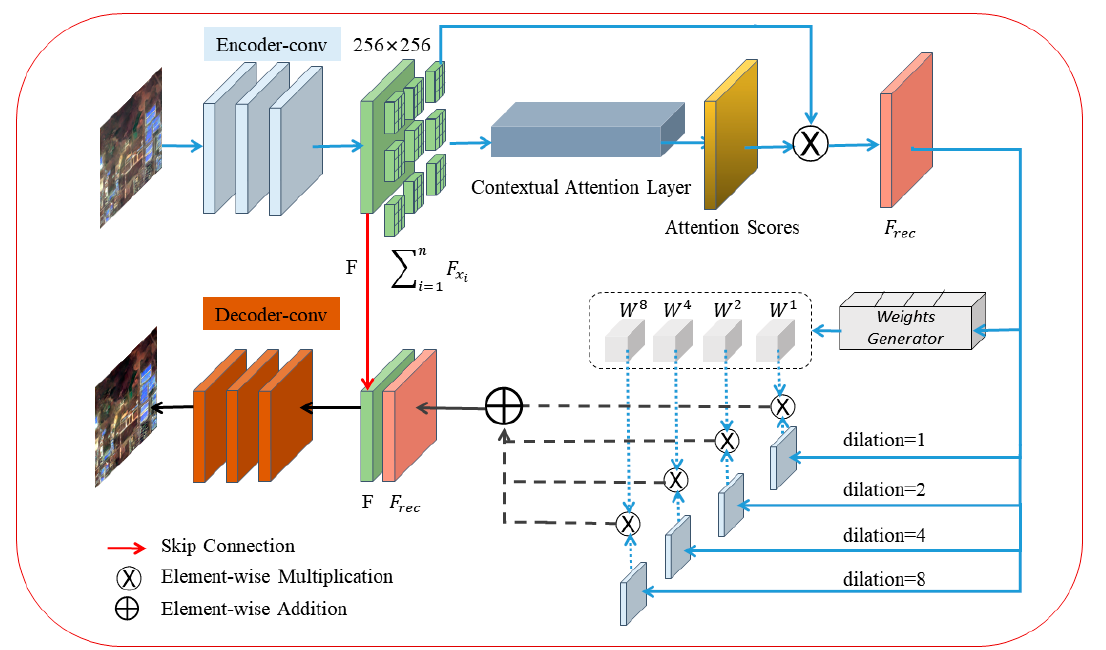
Figure 4. Structural diagram of the CFA module, which effectively models long-term spatial dependence through multiscale information.